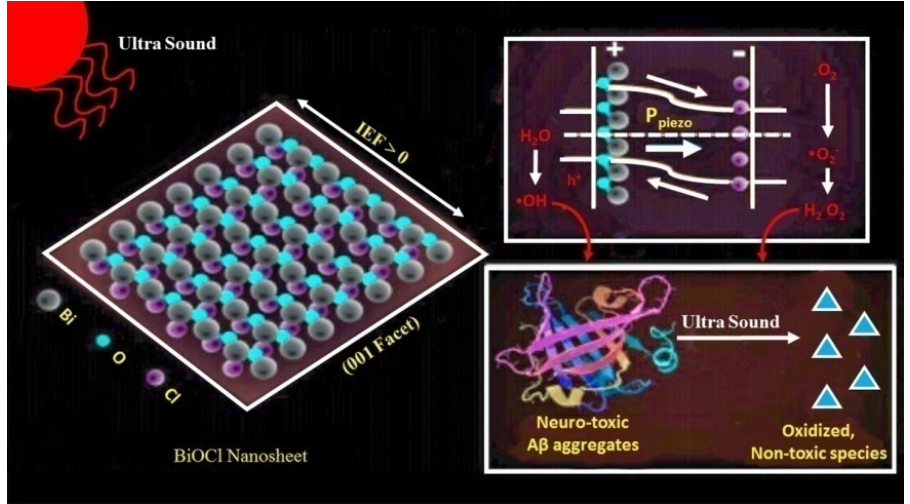
Figure 3. Piezoelectric breakdown of A β aggregates on the surface of bismuth oxychloride (BiOCl) nanosheets; BiOCl—bismuth oxychloride. nanosheets; BiOCl—bismuth